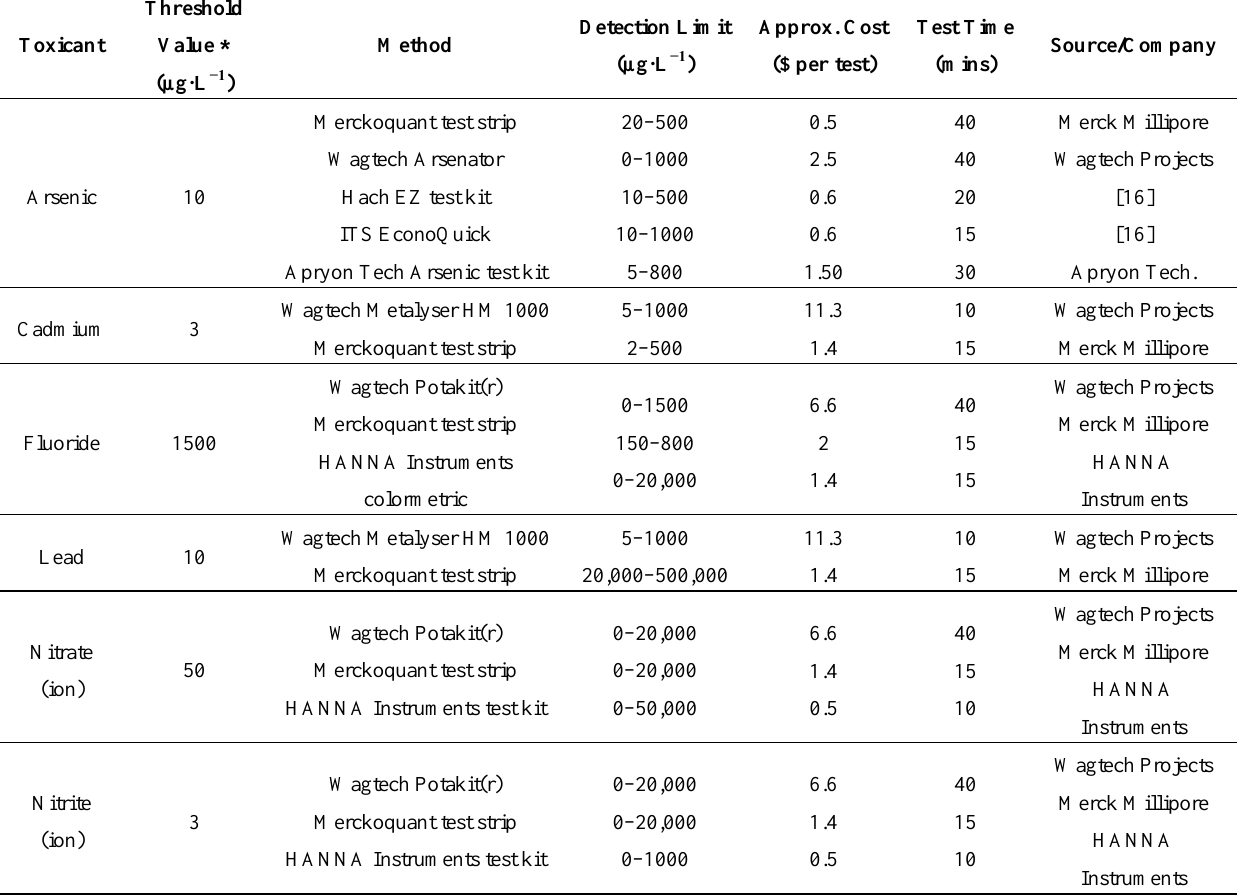
Table 1. Commercially used field based test methods for common